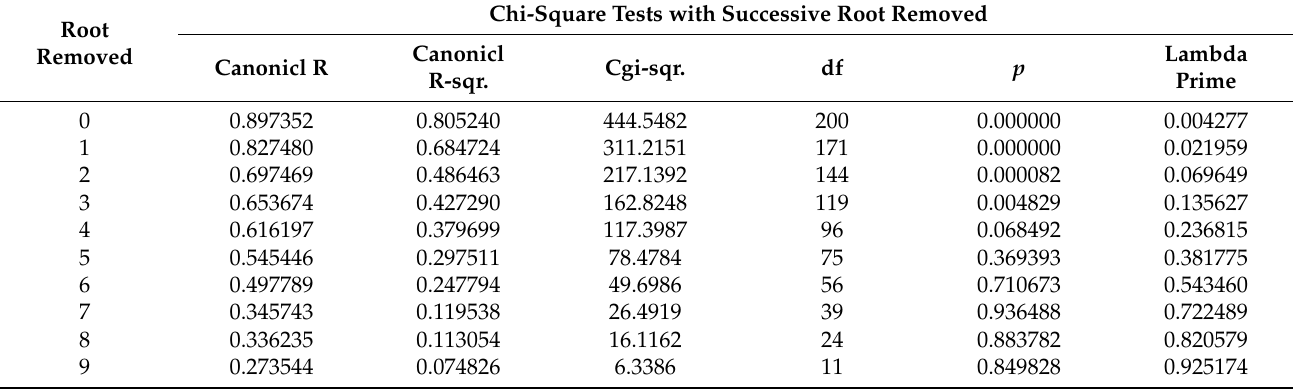
Table 2. Estimation of statistical significance of canonical correlations.